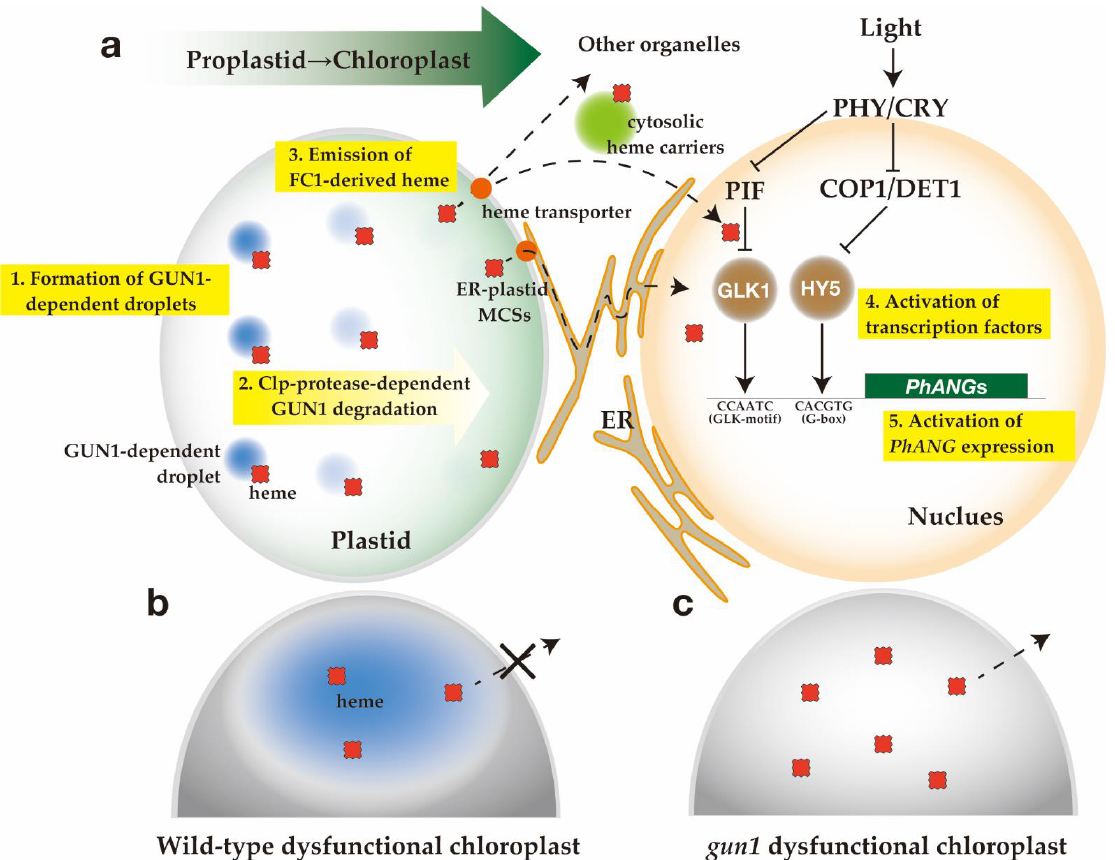
Figure 3. A hypothesis of the heme biogenic plastid-to-nucleus retrograde signaling pathway. ( a ) In plastids (left), the transition of proplastid to chloroplast is indicated from left to right. Blue circles indicate GUN1-dependent droplets and red symbols represent ferrochelatase (FC)1-dependent heme. 1. At the initial phase of proplastid to chloroplast transition, a putative GUN-dependent droplet may form in proplastids, which enhances nuclear-encoded polymerase (NEP)-dependent transcription and translation, import of nuclear-encoded proteins, and heme biosynthesis. Synthesized heme may bind to the GUN1-dependent droplets. 2. During chloroplast biogenesis, GUN1 is degraded by Clp-protease-dependent manner, causing disappearance of the blue circles. 3. FC1-derived hemes bound to GUN1 condensates were released and emitted from plastids via cytosolic or ER-plastid membrane contact sites (MCSs)-dependent pathway (dashed lines) through a plastid-envelop-localized putative transporter (orange circles). In the cytosolic pathway, heme may bind to cytosolic heme carrier proteins (green circles) to reach other organelles. 4. In the nucleus, heme may inactivate PIFs or activate transcription factors, GLK1, and/or HY5. 5. Consequently, PhANG expression is activated. ( b ) In the wild type, when chloroplasts are rendered dysfunctional by inhibitor treatments, Clp-protease-dependent degradation is protected resulting in the dispersion of the GUN1 droplet (blue circle), as well as retention of heme (red symbols) in plastids. ( c ) In gun1 , when the chloroplasts become dysfunctional, heme can be emitted from plastids because the GUN1-dependent condensates are